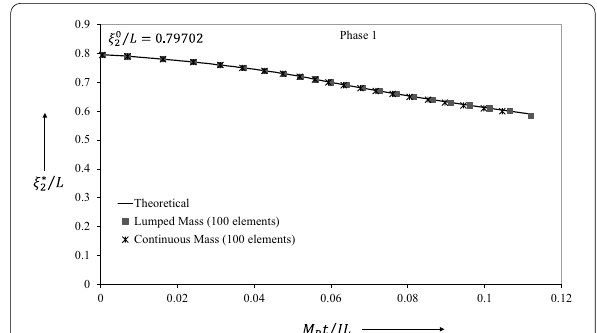
Fig. 15 Movement of plastic hinge away from simple support ( P 0 = 12.5 P c ) .